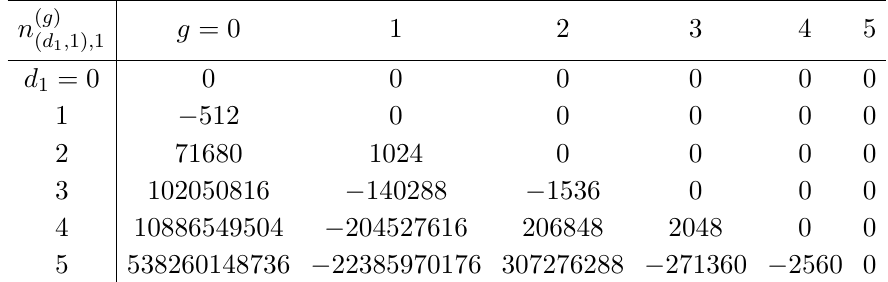
Table 9 . Torsion refined Gopakumar-Vafa invariants at base degree one with Z 2 charge 1